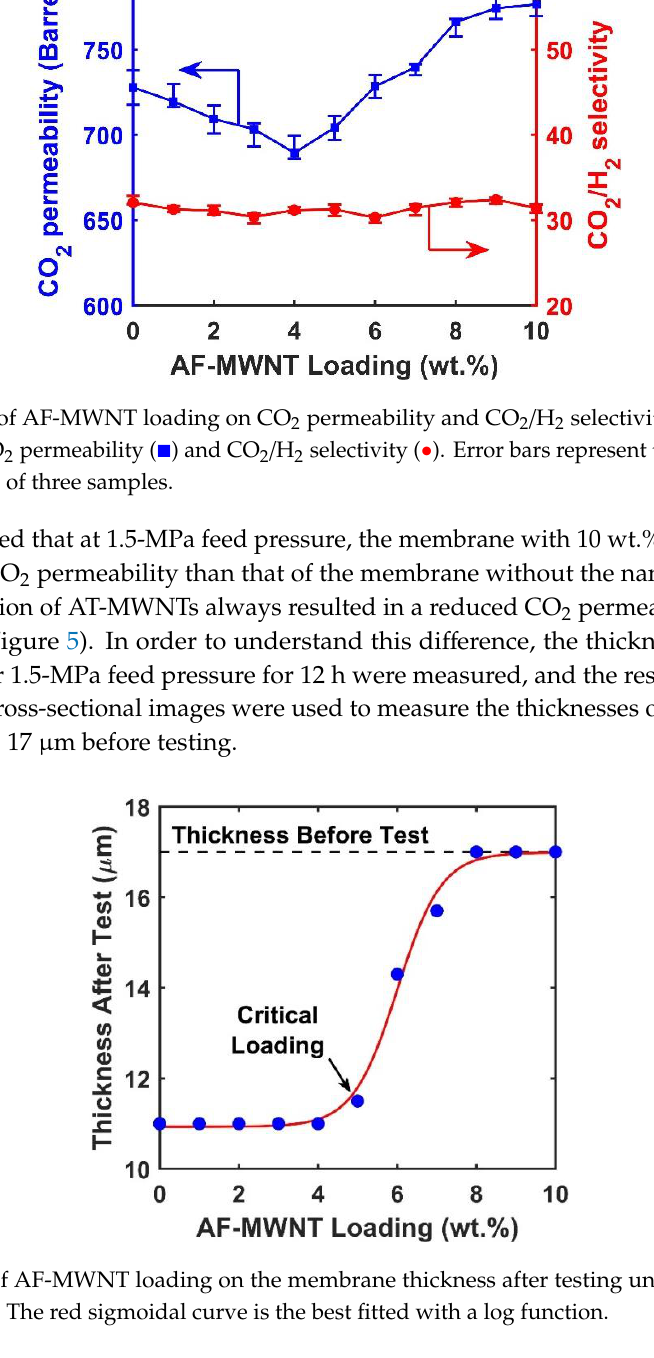
Figure 7. Effect of AF-MWNT loading on the membrane thickness after testing under 1.5-MPa feed pressure for 12 h. The red sigmoidal curve is the best fitted with a log function.